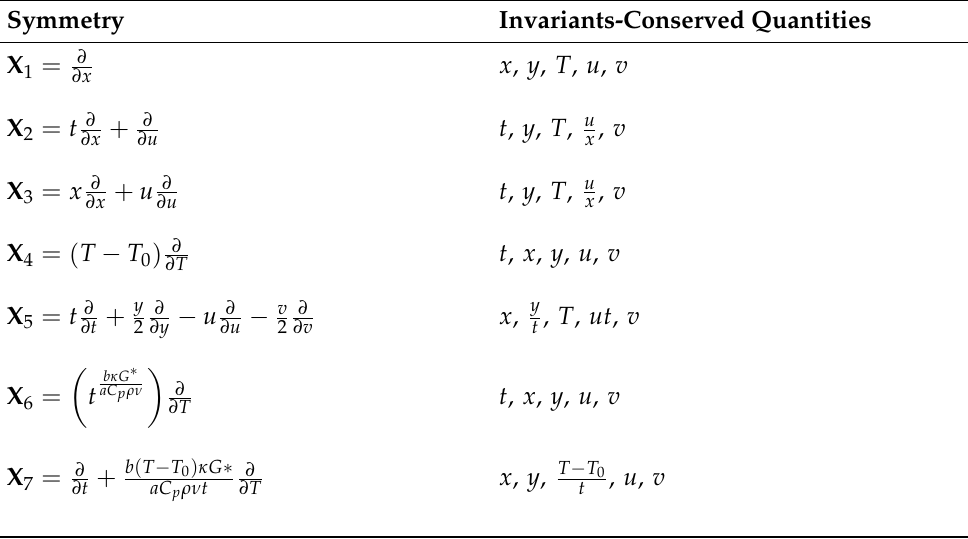
Table 1. Lie point symmetry generators and invariants.